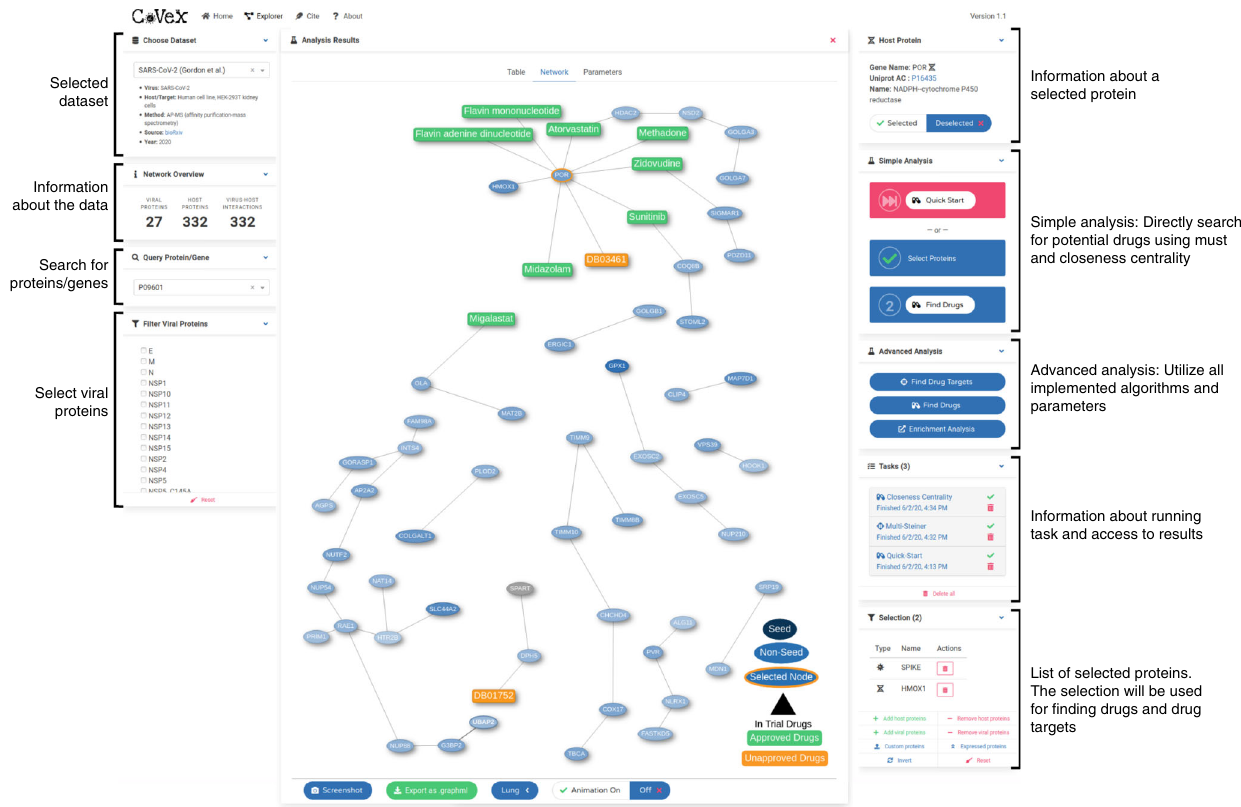
Fig. 2 The CoVex online platform. The network view (middle) shows drug candidates (green nodes) that were found using closeness centrality on a set of proteins (blue nodes), which resulted from a multi-Steiner tree computation with all viral proteins as seeds (not shown here). Therefore, drugs targeting these seeds might be able to interrupt the viral life cycle progression. Here we colored nodes based on lung-tissue-speci fi c median gene expression according to